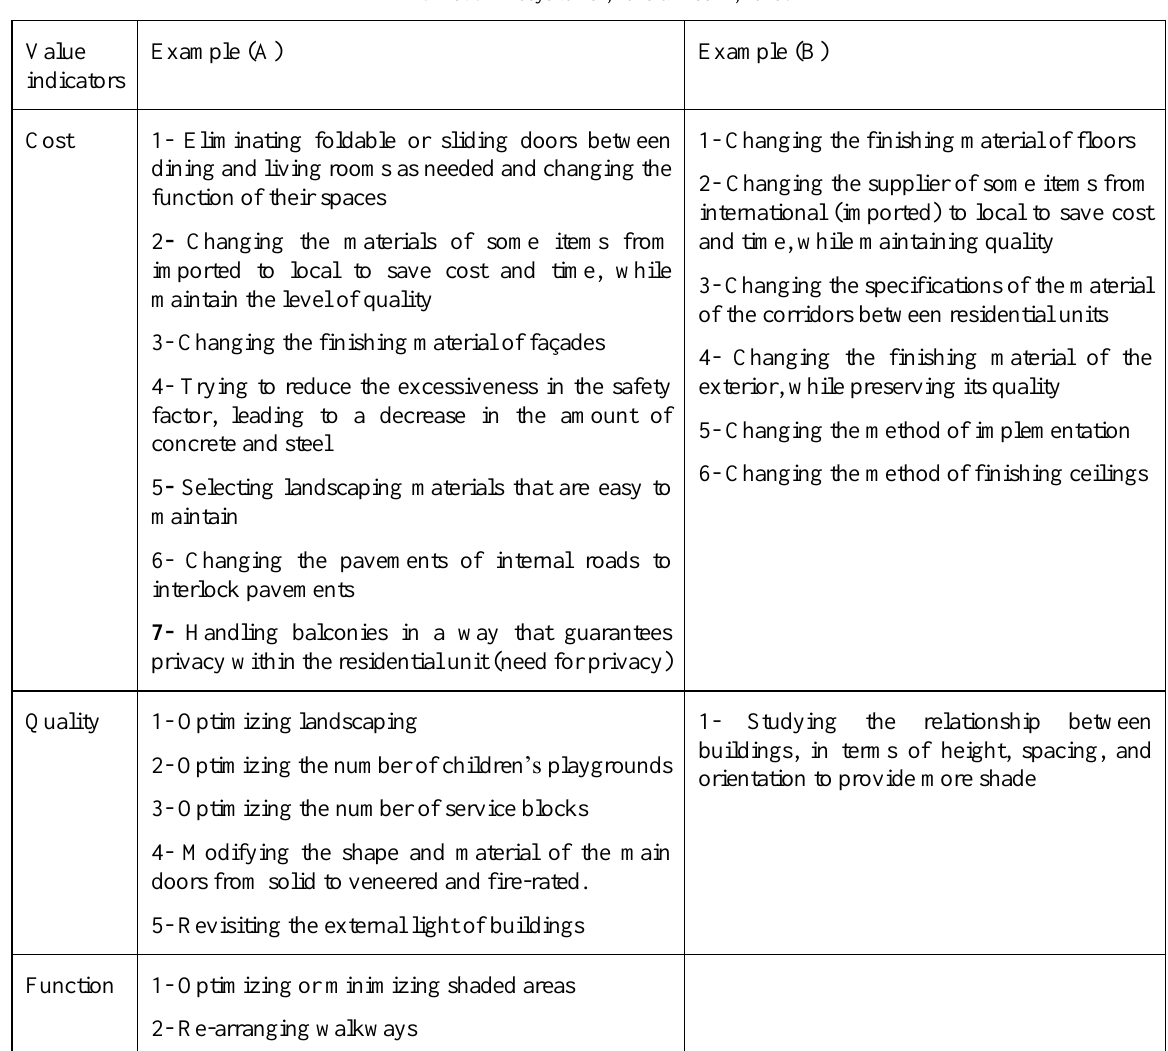
Table 2. Summary of proposal ideas after applying the creativity and evaluation phases on the two examples. Source: Authors as per the information in Jeyakumar, 2013 & Bashir, 2015.